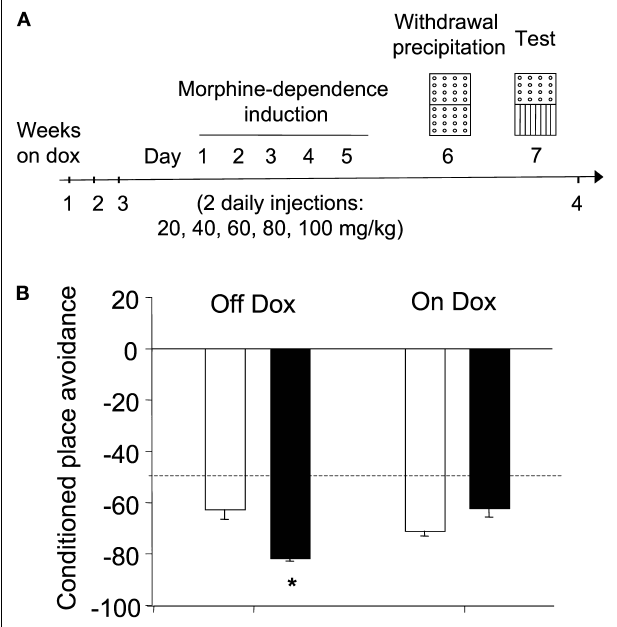
FIGURE 5 | Conditioned place avoidance. (A) Scheme depicting the behavioral training and treatment groups used in the conditioned place avoidance (CPA) procedure. Although for clarity the scheme presents the “holes” fl oor as CS + , this factor was counterbalanced across genotypes and dox treatment (see Section “Materials and Methods” for further details). (B) CPA was evaluated as the percent of time spent in the environment paired to morphine withdrawal during a preference test conducted 24 h after the last conditioning session but, for clarity, those data were arithmetically transformed (CPA = % time spent in CS + minus 100%). The black and white bars depict the results for ACREB-St and littermate control mice, respectively. The horizontal dotted line indicates the indifference (e.g., 50%) point. * p < 0.05 as compared to all other